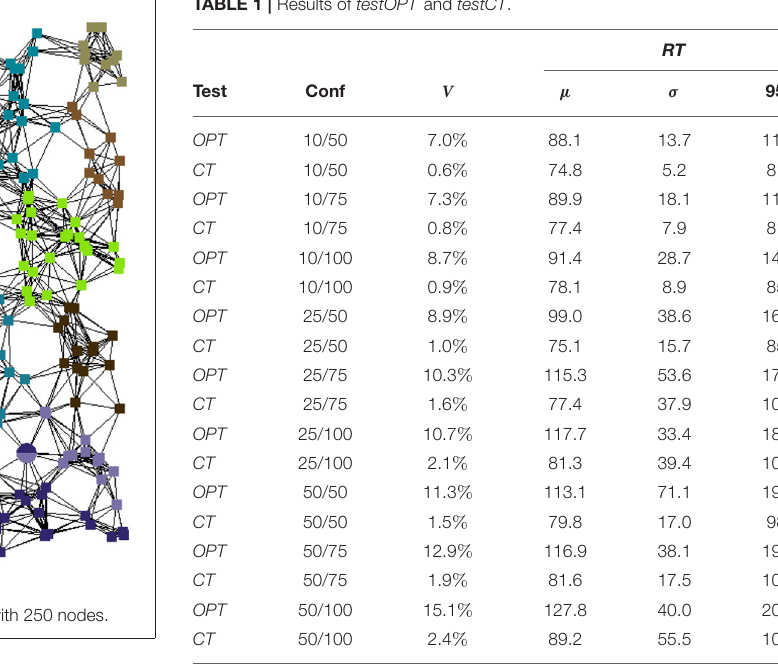
TABLE 1 | Results of testOPT and testCT